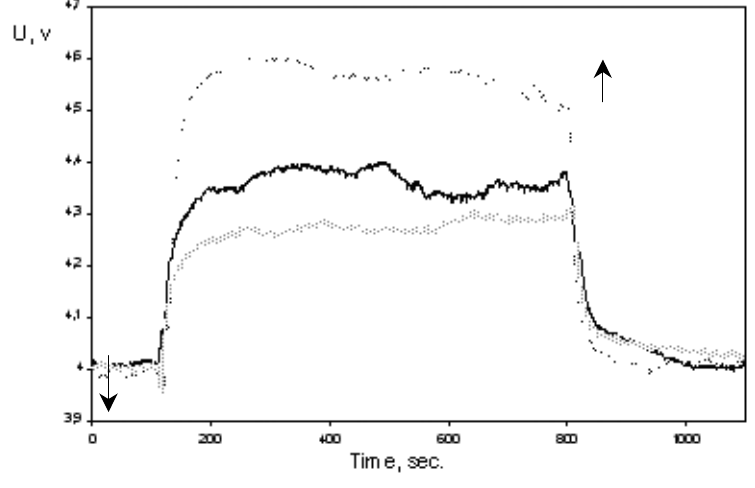
Figure. 2 Sensor response for 50 ppb of ozone in the air, when Teflon tubes of various lengths are used: 1 cm (upper curve), 500 cm (middle curve), 1000 cm (bottom curve). (cid:8) - ozone generator ON, (cid:9) - ozone generator